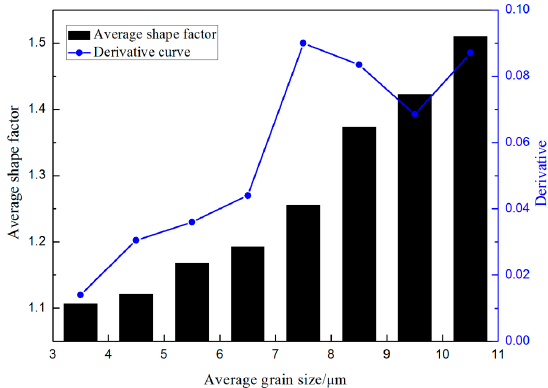
Figure 12. Average shape factor for the different range of grain sizes.